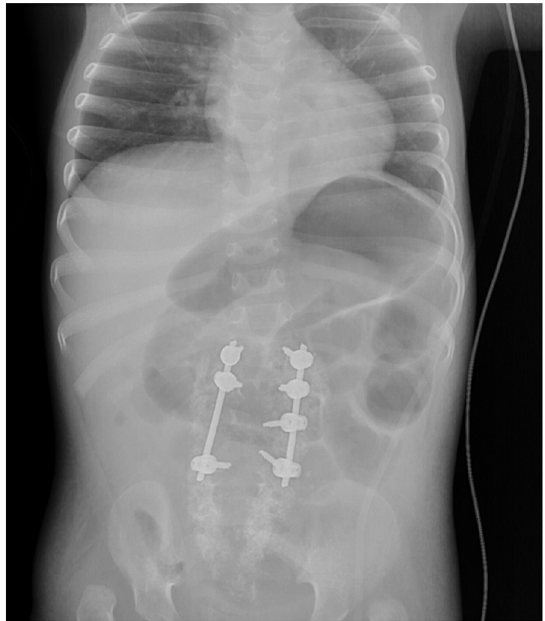
Fig. 1 Abdomen X‑ray image showing proximally dilated small bowels and distally collapsed large